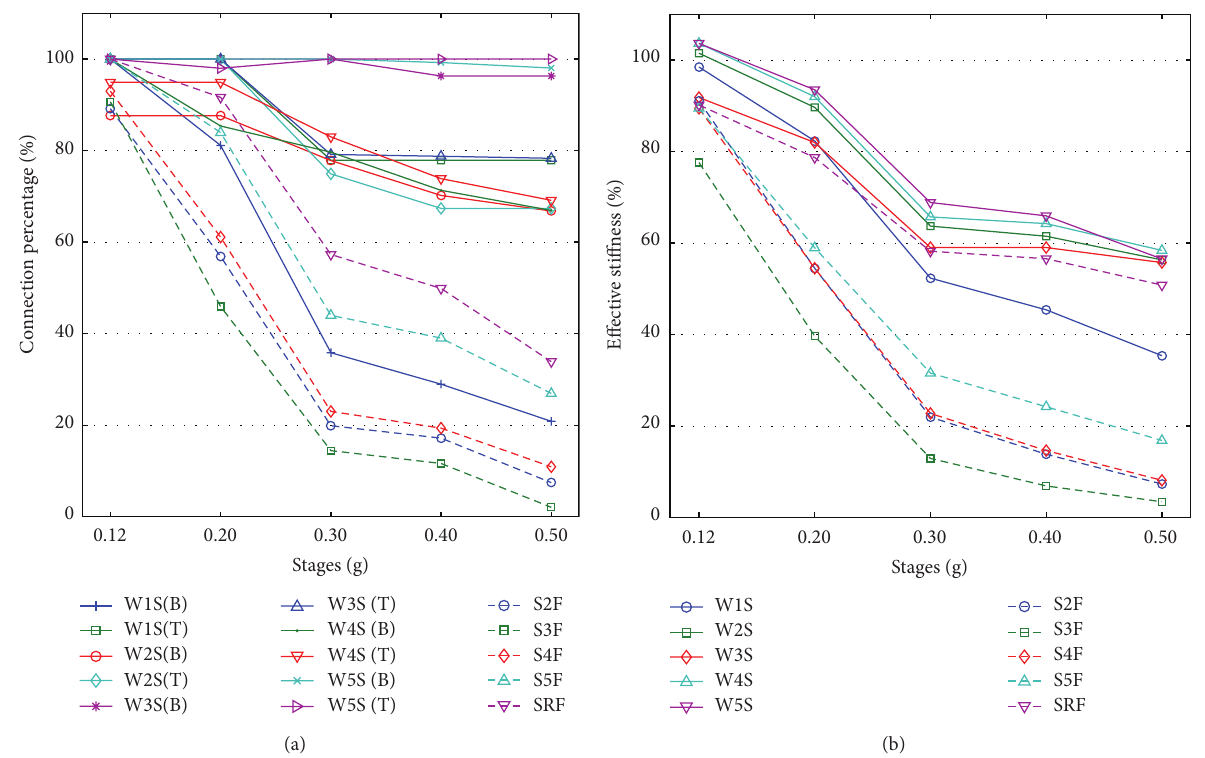
Figure 7: Change in stiffness ratios: (a) FS model, and (b) RS